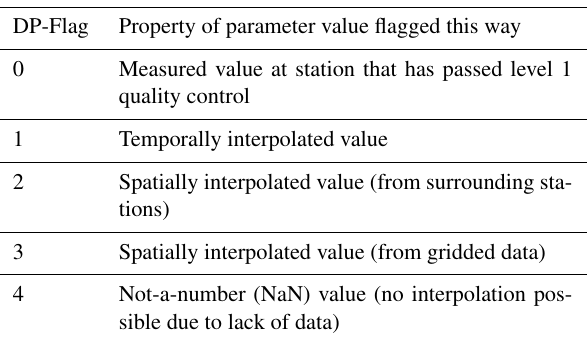
Table 6. Data product flags for level 2 basis data and corresponding